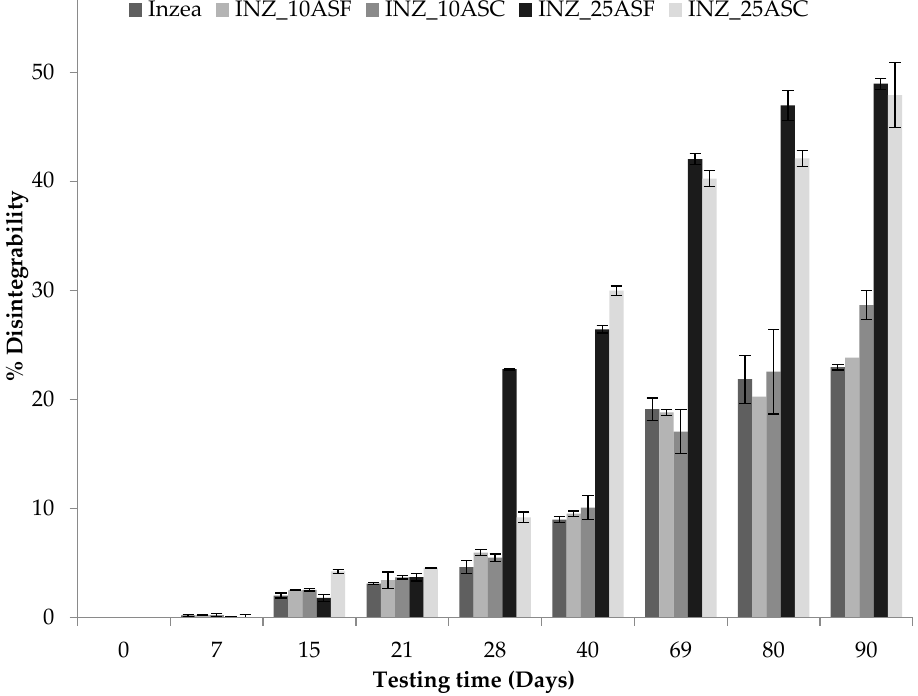
Figure 7. Disintegrability (%) of INZEA-based biocomposites with 10 and 25 wt % of ASP at two grinding levels (F, C) as a function of degradation time under composting conditions at 58 °C (mean ± SD, n = 3).